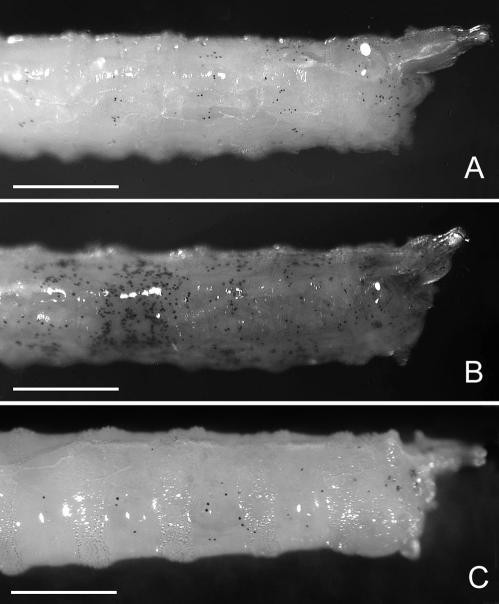
Crystal Cells in Late Third Instar LarvaeCrystal cells were visualized by heating larvae of different genotypes at 60 °C for 10 min [46]. (A) Wild-type larva, (B) adgf-a single mutant, (C) adoR adgf-a double mutant (scale bar, 0.5 mm).